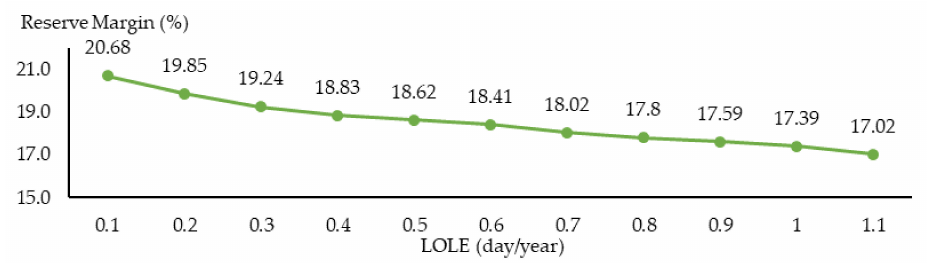
Figure 12. Reliability indices of generation expansion plan with LOLE < 0.7 day/years.